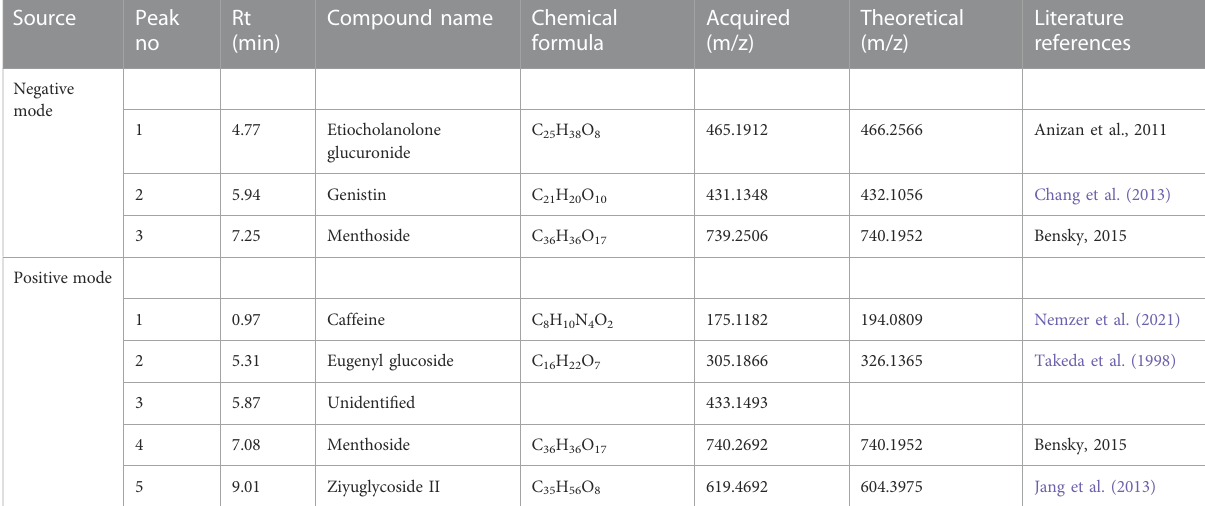
TABLE 2 UPLC-QTOF-MS pro fi les of M. oppositifolia hydro-alcohol extract (analysis in both negative and positive mode).